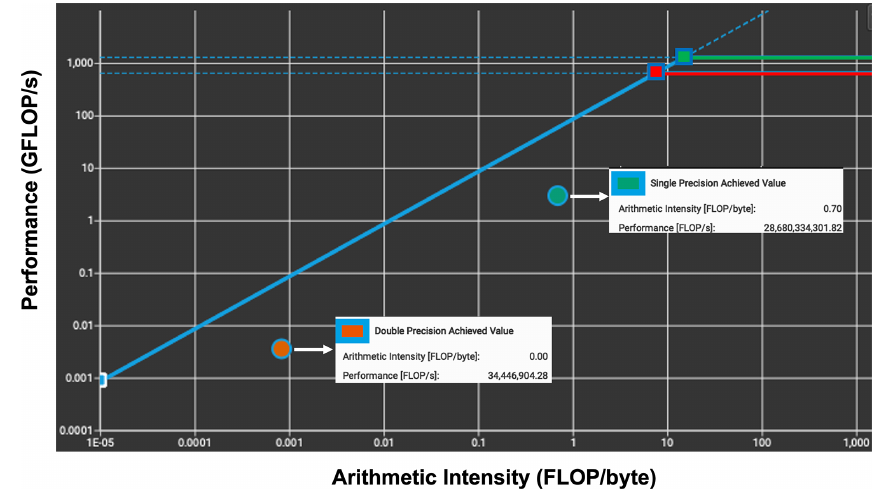
Figure 8. Roofline model for the W3SRCEMD kernel from NVIDIA Nsight Compute. The red and green dots are the double- and single- precision values,